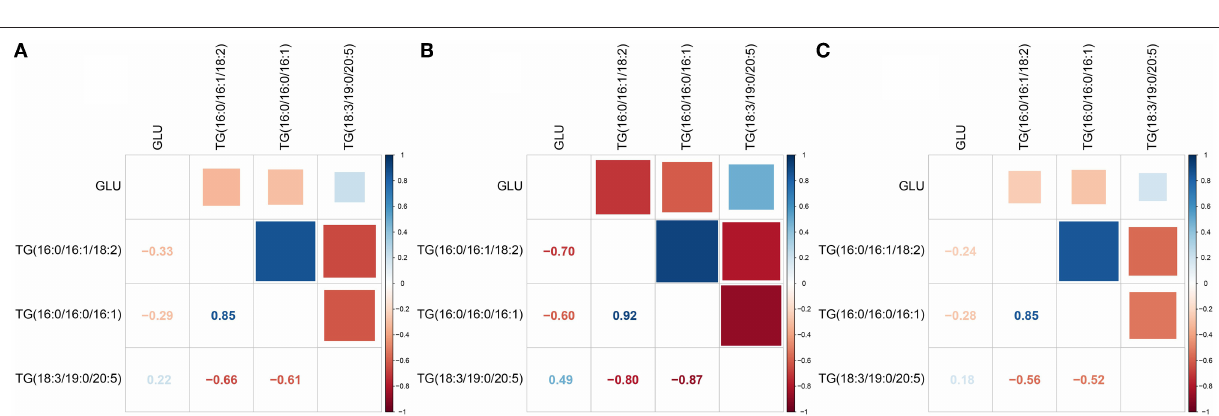
Frontiers in Nutrition |